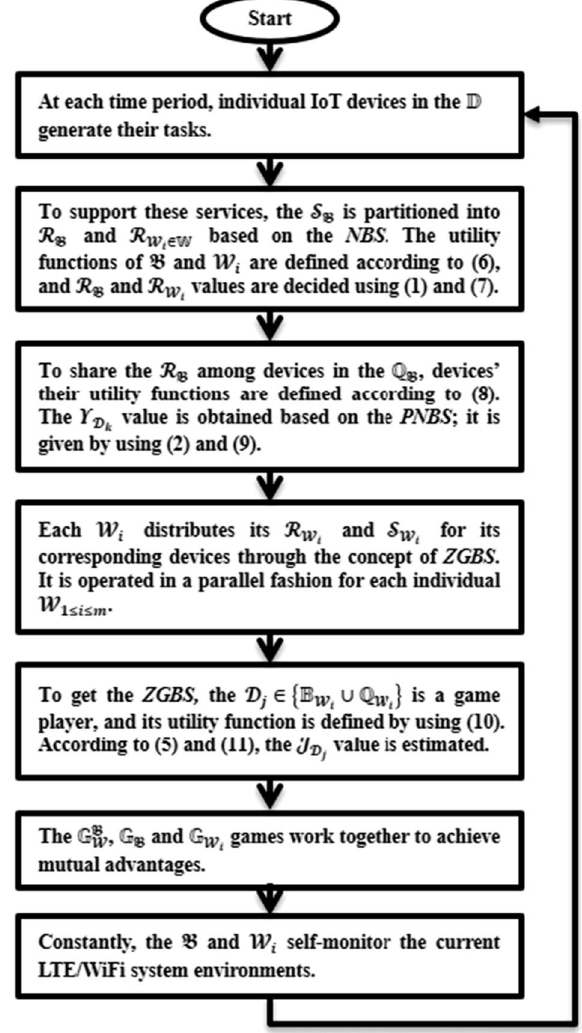
Fig. 2 Flowchart of proposed